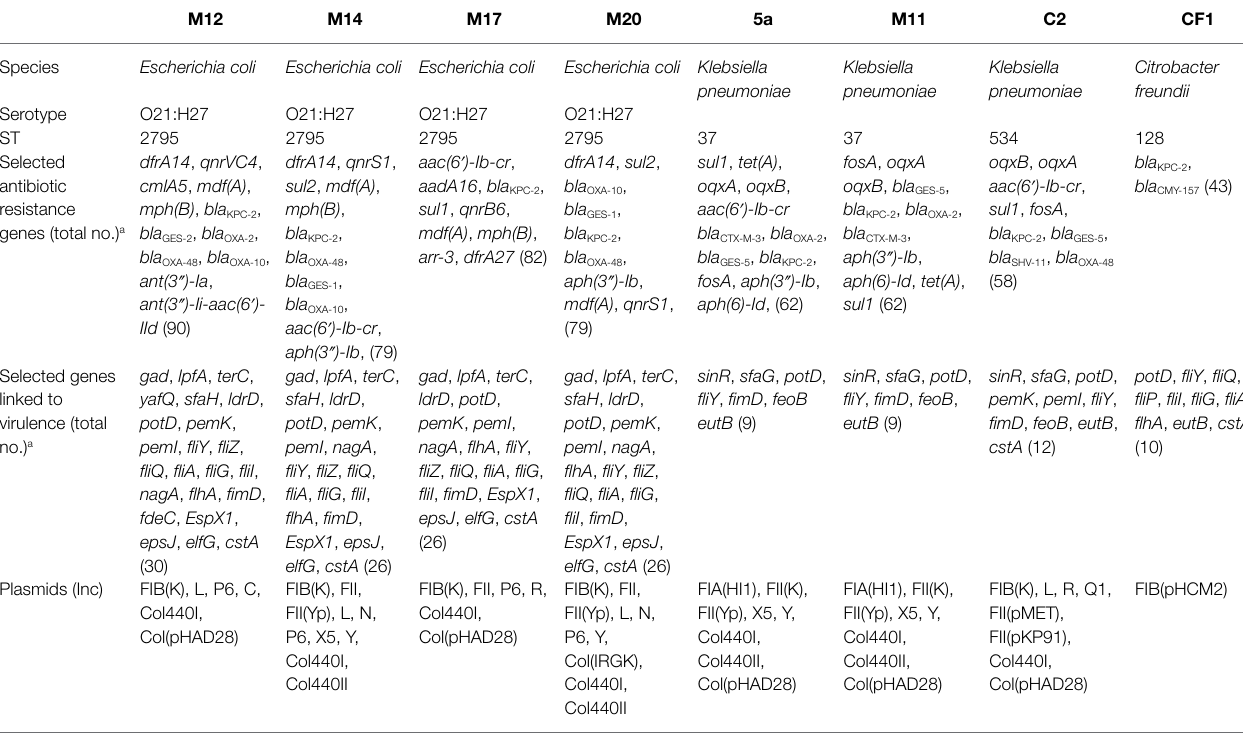
TABLE 3 | Molecular characteristics of eight whole-genome sequenced CRE